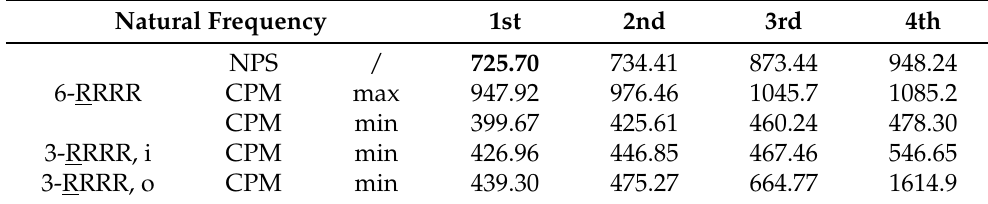
Table 8. Natural frequency of the 6-RRRR CPM and NPS using the FEM. Natural Frequency 1st 2nd 3rd